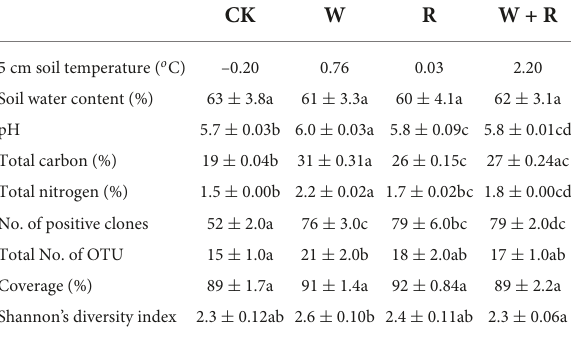
TABLE 1 Soil property and diversity analysis of clone libraries under climate change